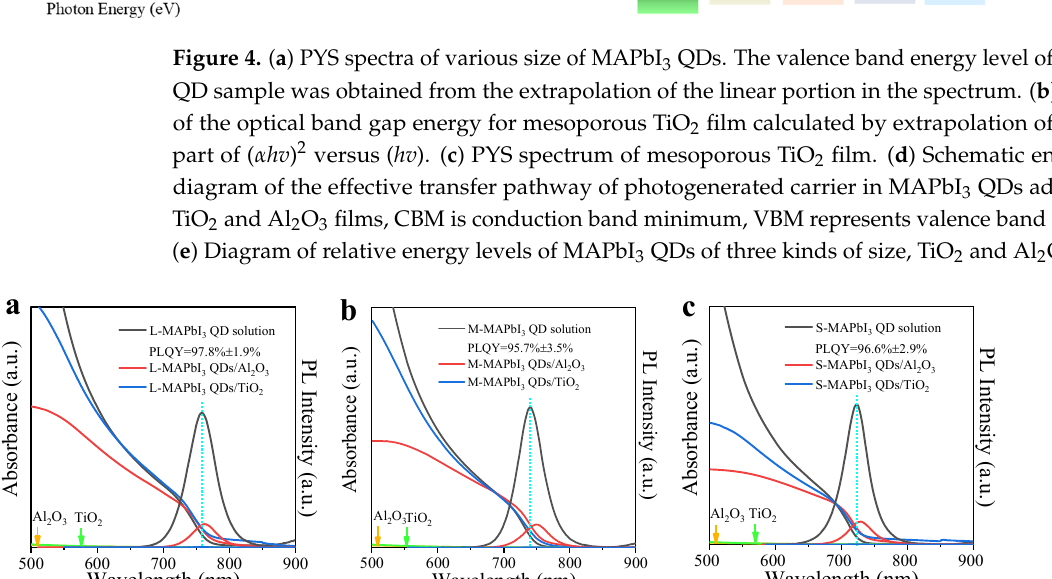
Figure 5. The absorption and PL spectra of ( a ) L-MAPbI 3 QD solution, L-MAPbI 3 QDs/TiO 2 and L- MAPbI 3 QDs/Al 2 O 3 , ( b ) M-MAPbI 3 QD solution, M-MAPbI 3 QDs/TiO 2 and M-MAPbI 3 QDs/Al 2 O 3 , ( c ) S-MAPbI 3 QD solution, S-MAPbI 3 QDs/TiO 2 and S-MAPbI 3 QDs/Al 2 O 3 .